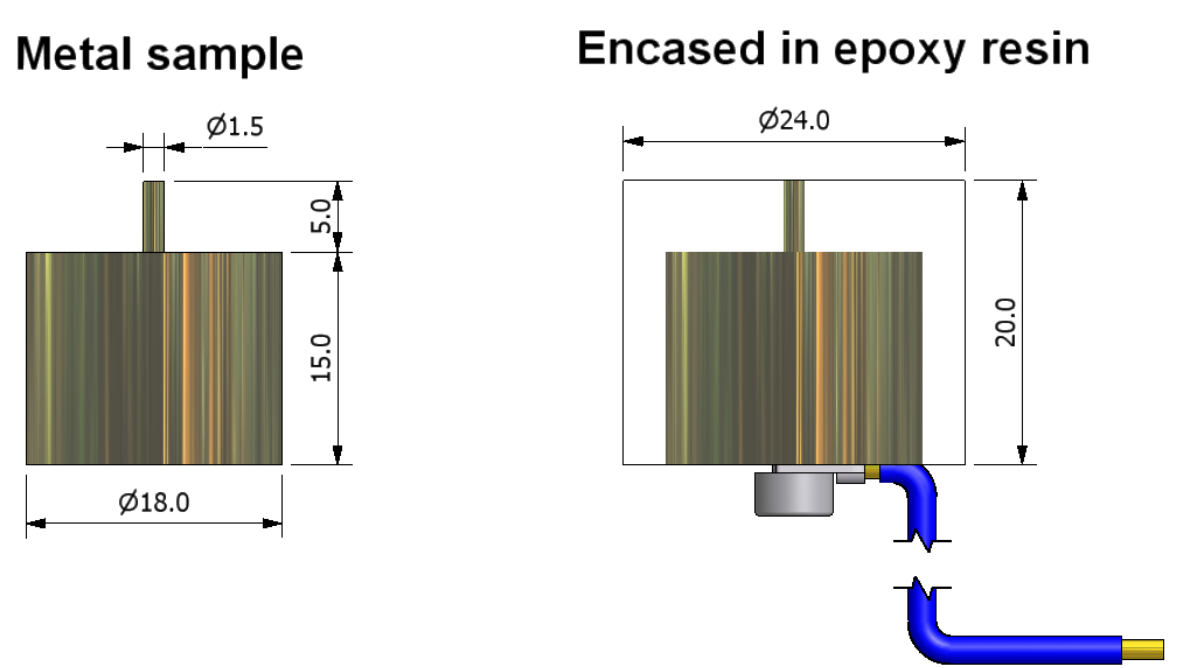
Figure 1. Pencil electrode assembly for accelerated corrosion experiments (all dimensions in